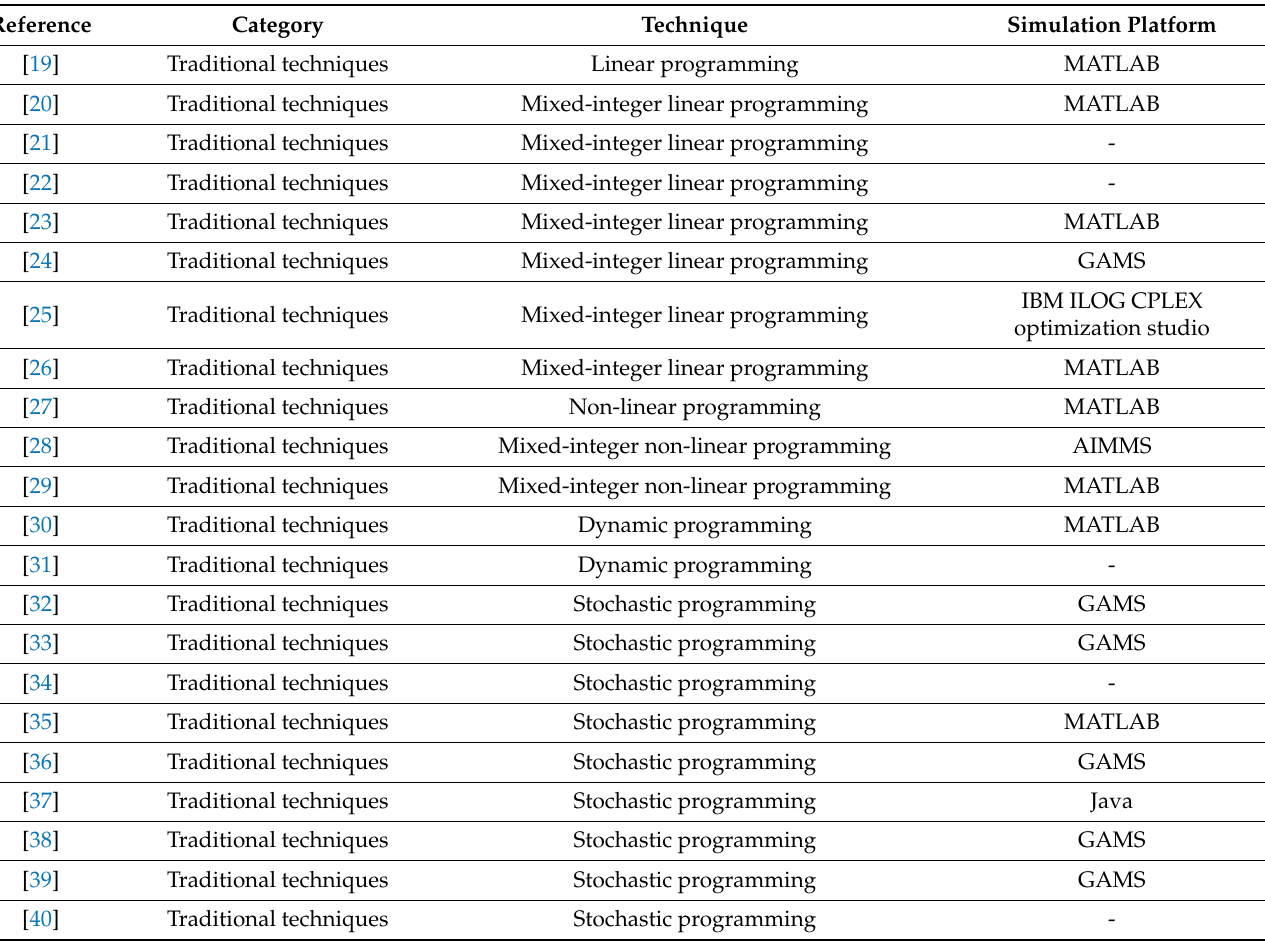
Table 5. Selected papers by category, technique, and simulation platform.